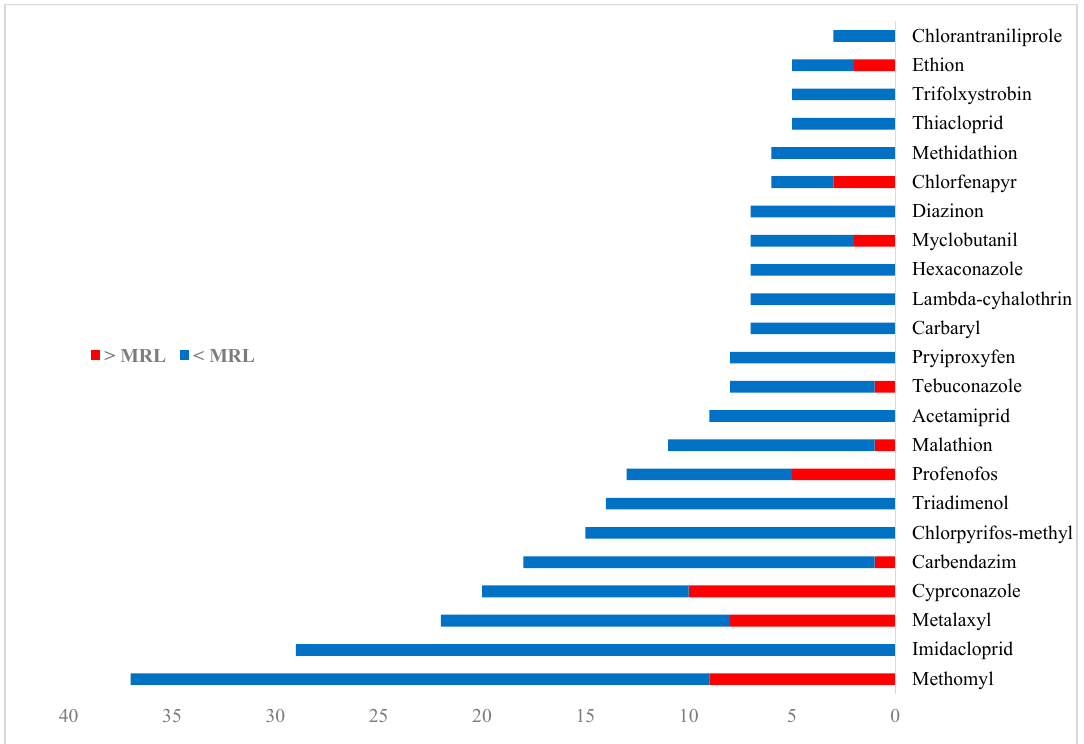
Figure 1. Frequency of the most-often-detected pesticides in the analyzed samples.